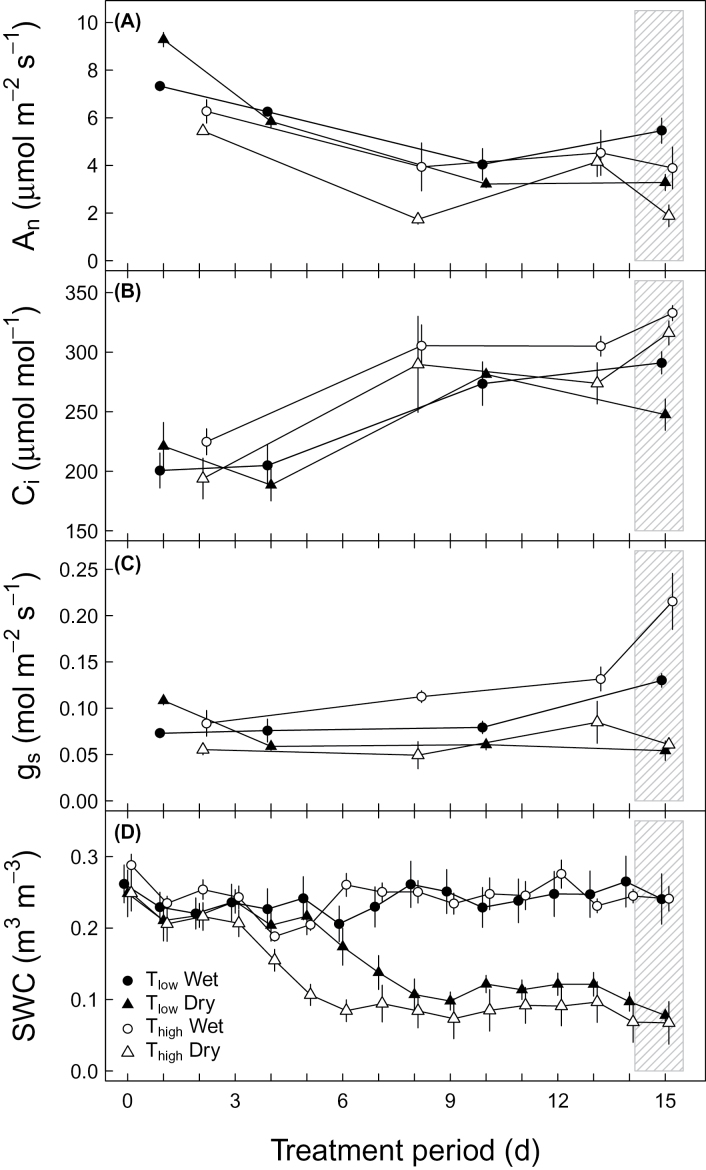
Physiological parameters under different environmental conditions during the treatment period: (A) net assimilation rate (A
n, µmol m-2 s-1), (B) intercellular CO2 concentration (C
i, µmol mol-1), (C) stomatal conductance (g
s, mol m-2 s-1), (D) volumetric soil water content (SWC, m3/m-3). Potato plants were treated with a combination of Tlow (low temperature; closed symbols), Thigh (high temperature; open symbols), and wet (circles) or dry (triangles) conditions. Boxed areas indicate the sampling period. Means ±SE are given (n=3).